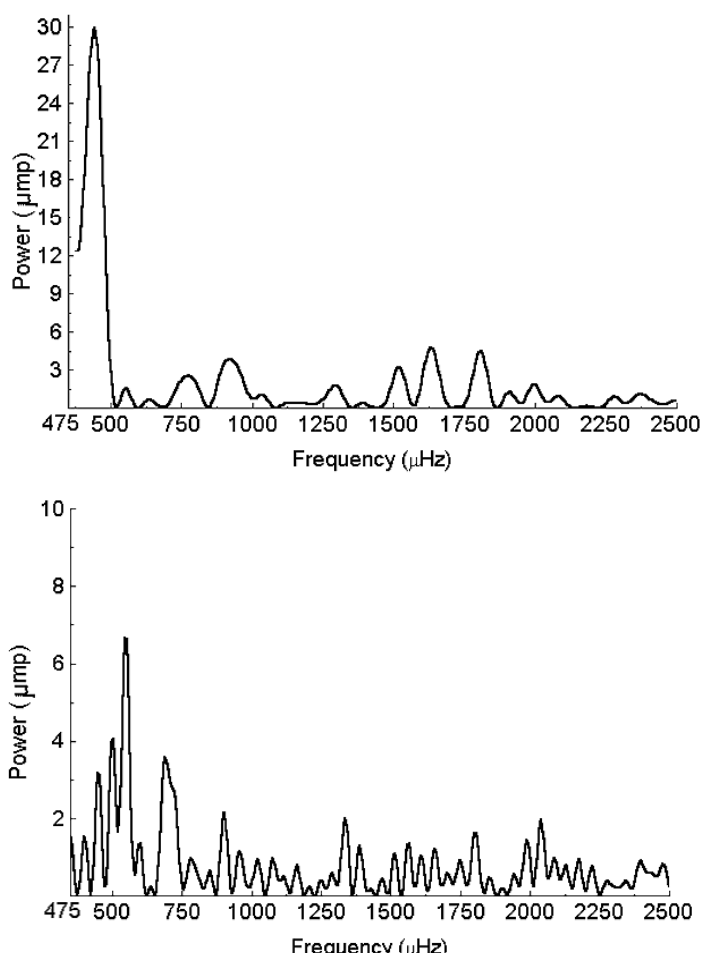
Fig. 6. FT of NGC 246 from the consecutive nights at the IAC80. The upper panel shows the FT obtained from the September 17 run and the lower panel – from the September 18 run. The scales for power are